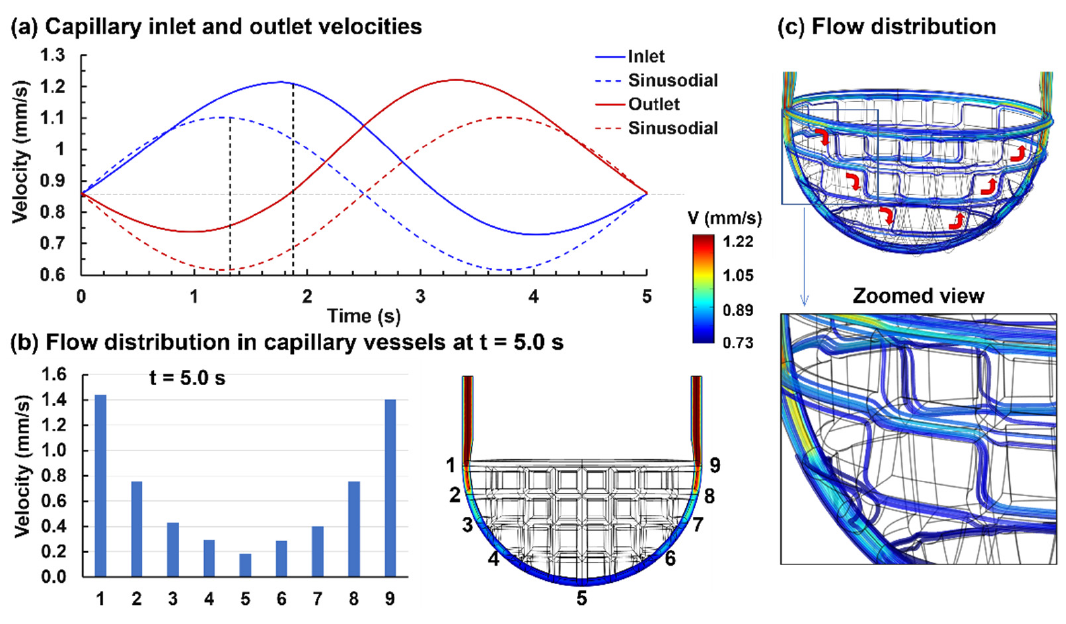
Figure 4. Perfusion distributions among capillaries within one breathing cycle: ( a ) phase shifts of the blood flow vs. a sinusoidal waveform at the inlet and outlet, ( b ) flow distribution in capillary vessels at the end of contraction ( t = 5.0 s), and ( c ) flow distribution within the capillary network.